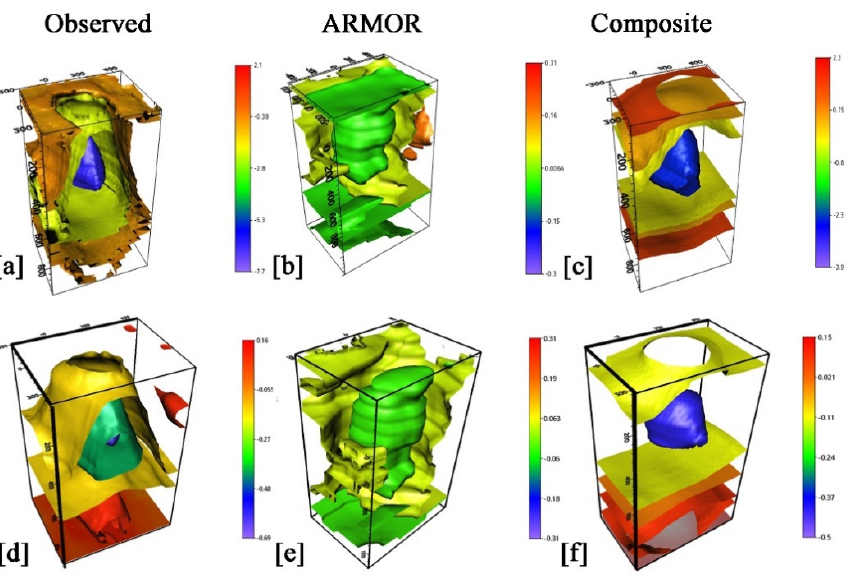
Figure 4. Three-dimensional structure: ( a ) observed temperature anomalies (°C); ( b ) ARMOR3D temperature anomalies (°C); ( c ) composite temperature anomalies (°C); ( d ) observed salinity anomalies (PSU); ( e ) ARMOR3D salinity anomalies (PSU); and ( f ) composite salinity anomalies (PSU). The color shading illustrate the temperature or salinity anomalies.